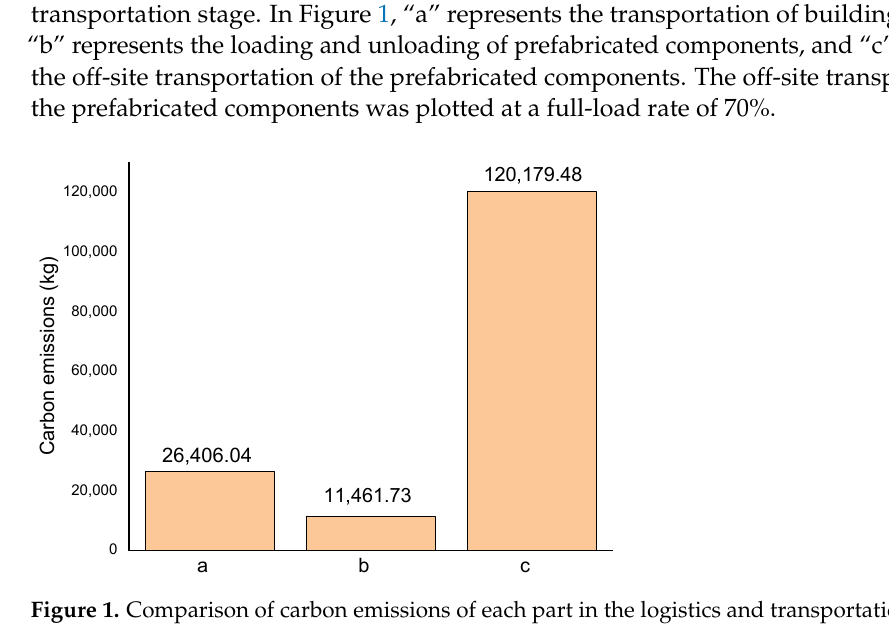
ferent full ‐ load rates.